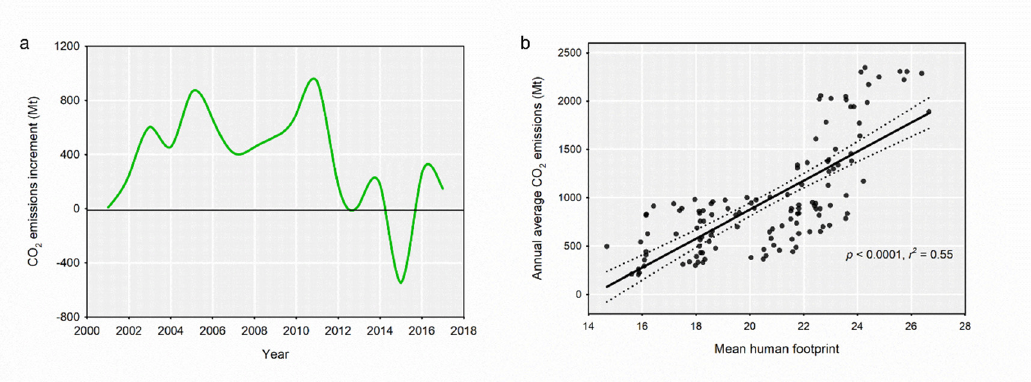
Figure 6. Trends in the ( a ) annual increase in CO 2 emissions and the ( b ) relationship between the average human footprint and average annual CO 2 emissions.